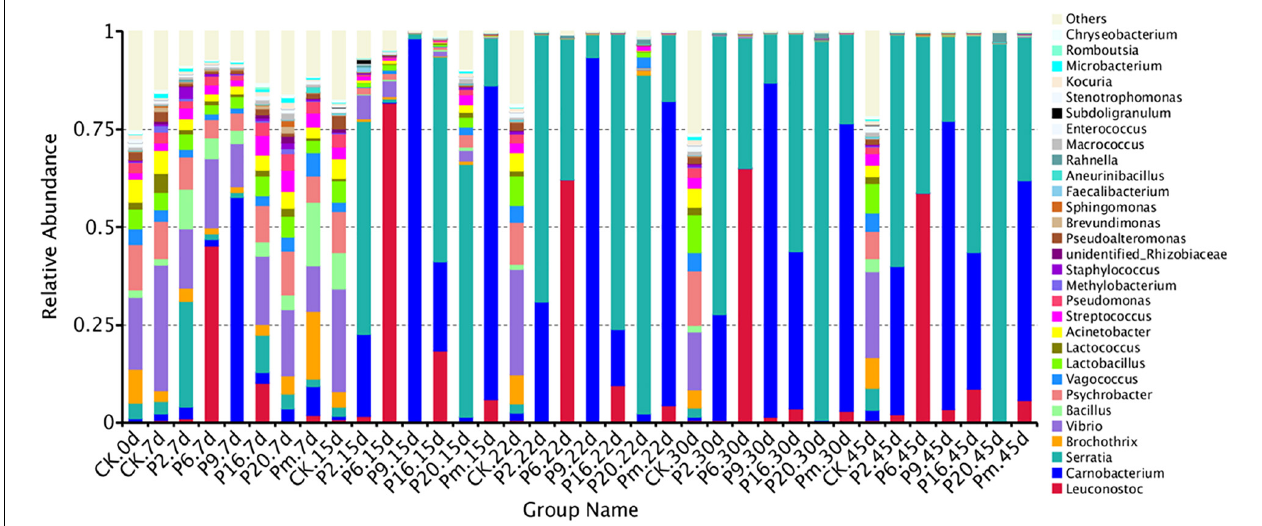
FIGURE 2 | Dynamics in relative abundance (%) of bacterial taxa at the phylum level in bacon inoculated with potential spoilage bacteria. Each bar represents the relative abundance of each group, below the top-30 abundances (at genus level) data were merged. CK, Control; P2, Staphylococcus xylosus ; P6, Leuconostoc mesenteroides ; P9, Carnobacterium maltaromaticum ; P16, Leuconostoc gelidum ; P20, Serratia liquefaciens ; Pm, The five strains in